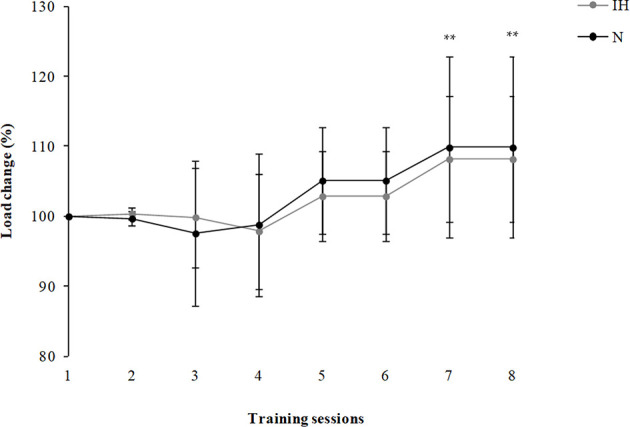
Change in the training load that elicits 1 m·s−1 of the mean propulsive velocity (MPV) expressed in percentage (%) for the 8 sessions of the resistance training program. **Significant differences among sessions (compared with the first session, P < 0.05) were noted for both groups.